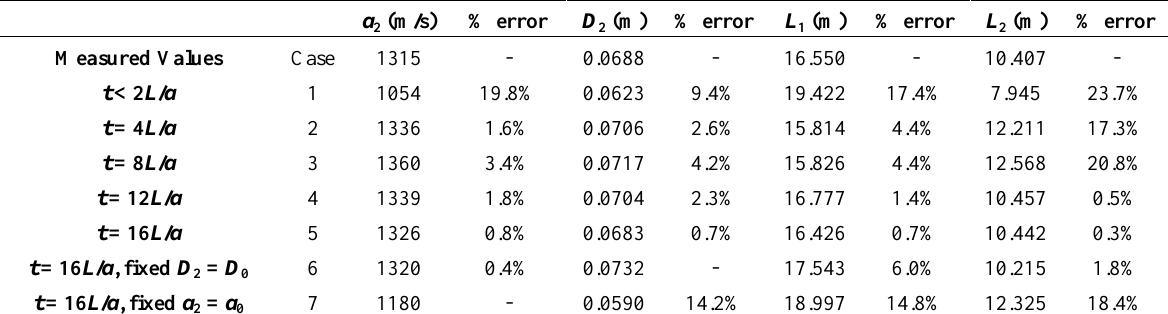
Table 1. Inverse transient analysis